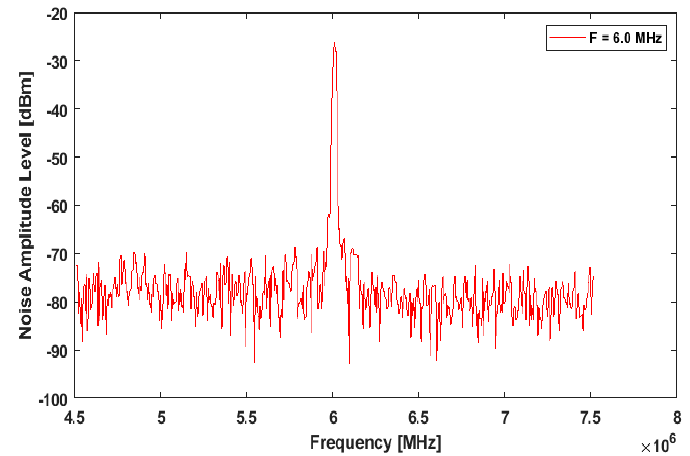
Figure 9. Waveform at 3 MHz.